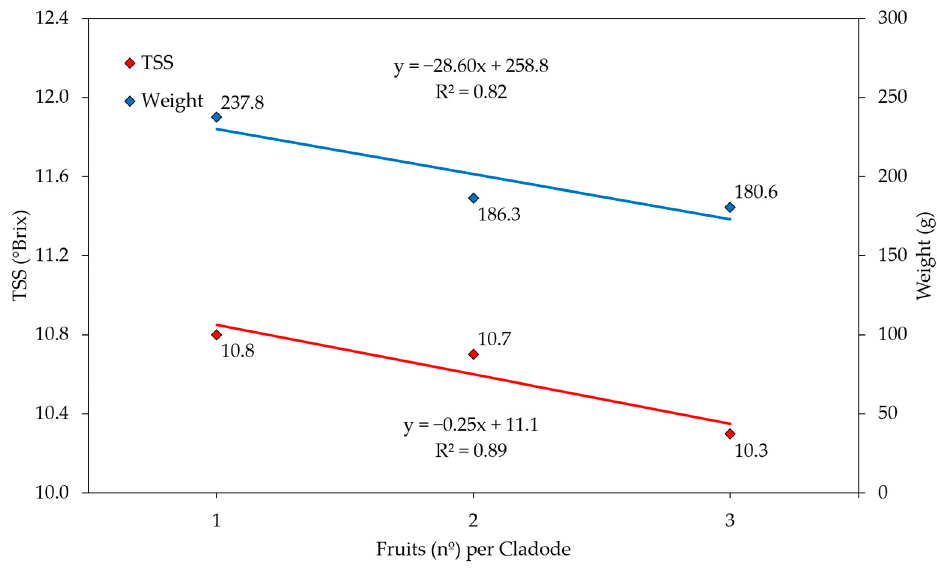
Figure 4. Fruit weight (g; in blue) and total soluble solid content (°Brix; in red) depending on the number of fruits per cladode.